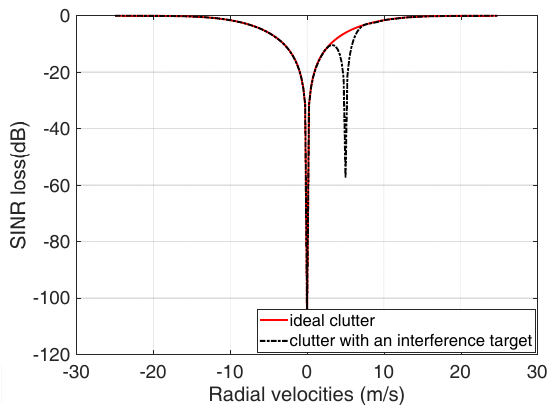
Figure 10. Comparison of the GMTI performance between the ideal clutter and the clutter with an interference